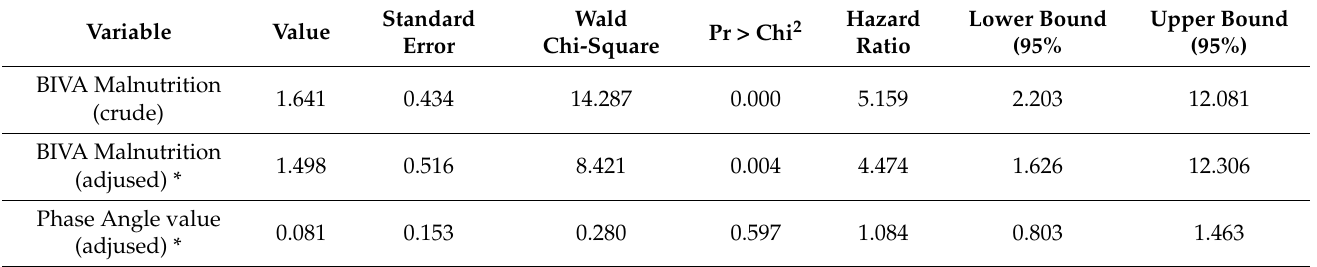
Table 5. Cox proportional hazard ratio for death at 60 days. Crude and correct for